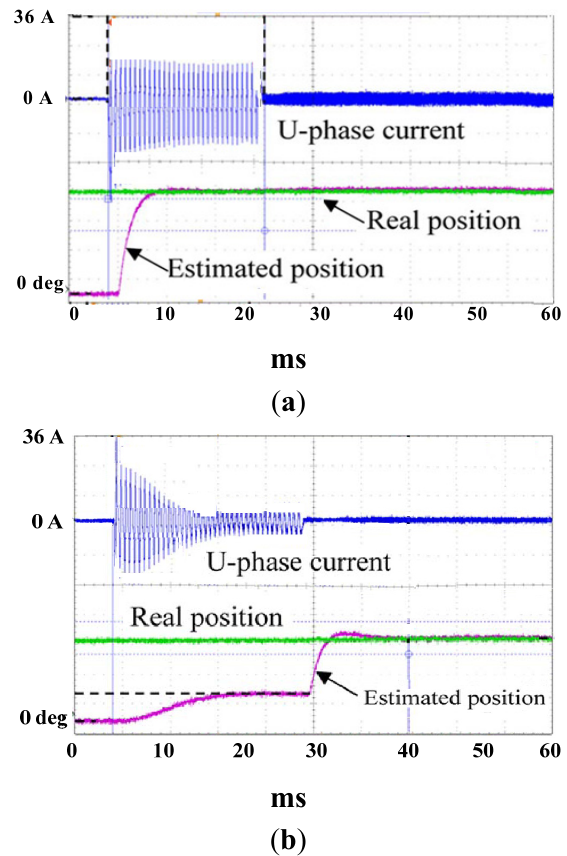
Figure 16. Initial rotor position estimation. ( a ) Initial polarity is N pole; and ( b ) Initial polarity is S